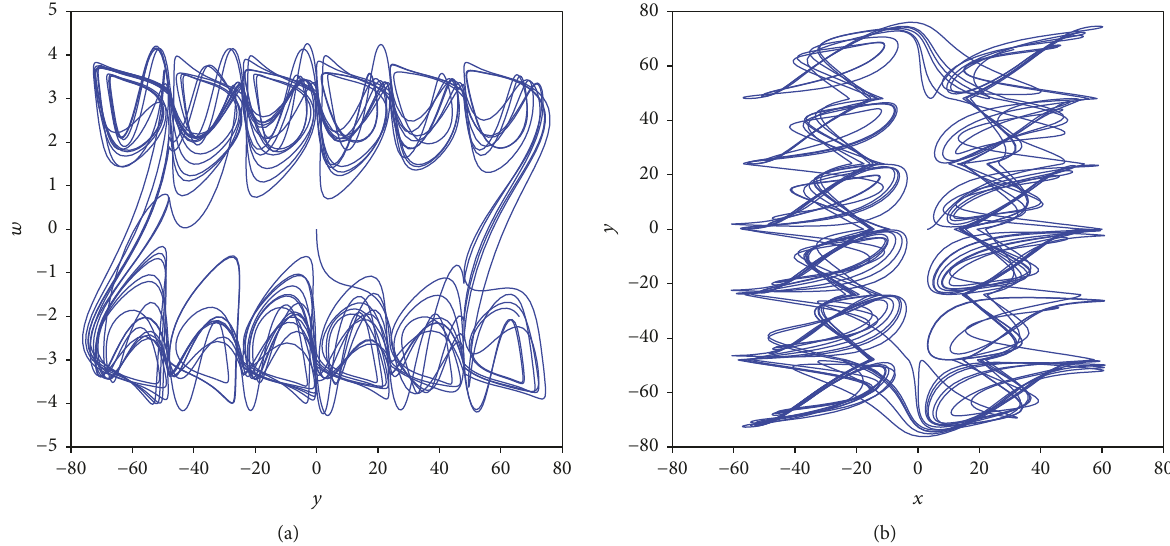
Figure 7: Projections of the 2 × 6 multiscroll hyperchaotic attractors onto the y , w and x , y plane. (a) y , w plane. (b) x , y